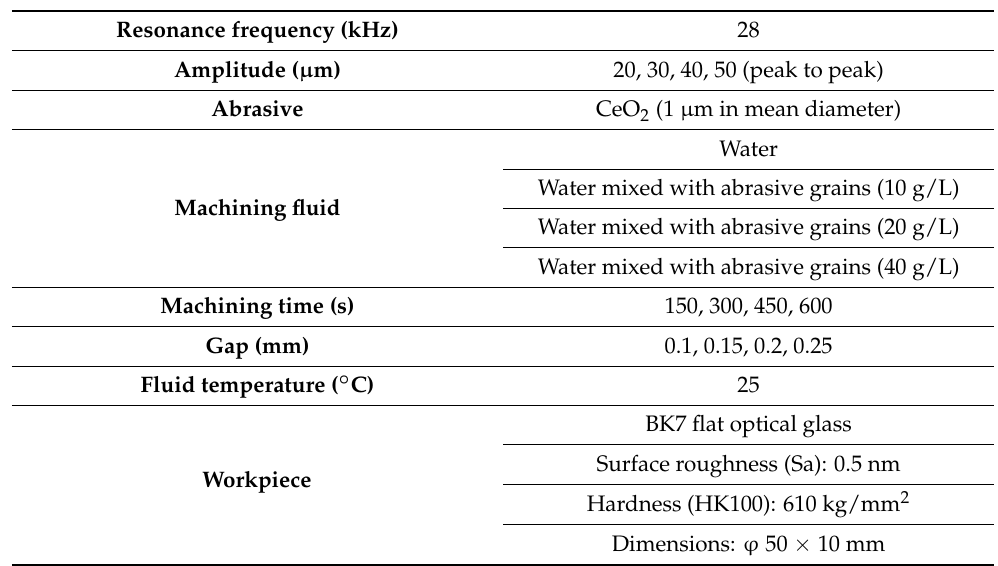
Figure 6. Experimental setup. Table 2. Experimental conditions.